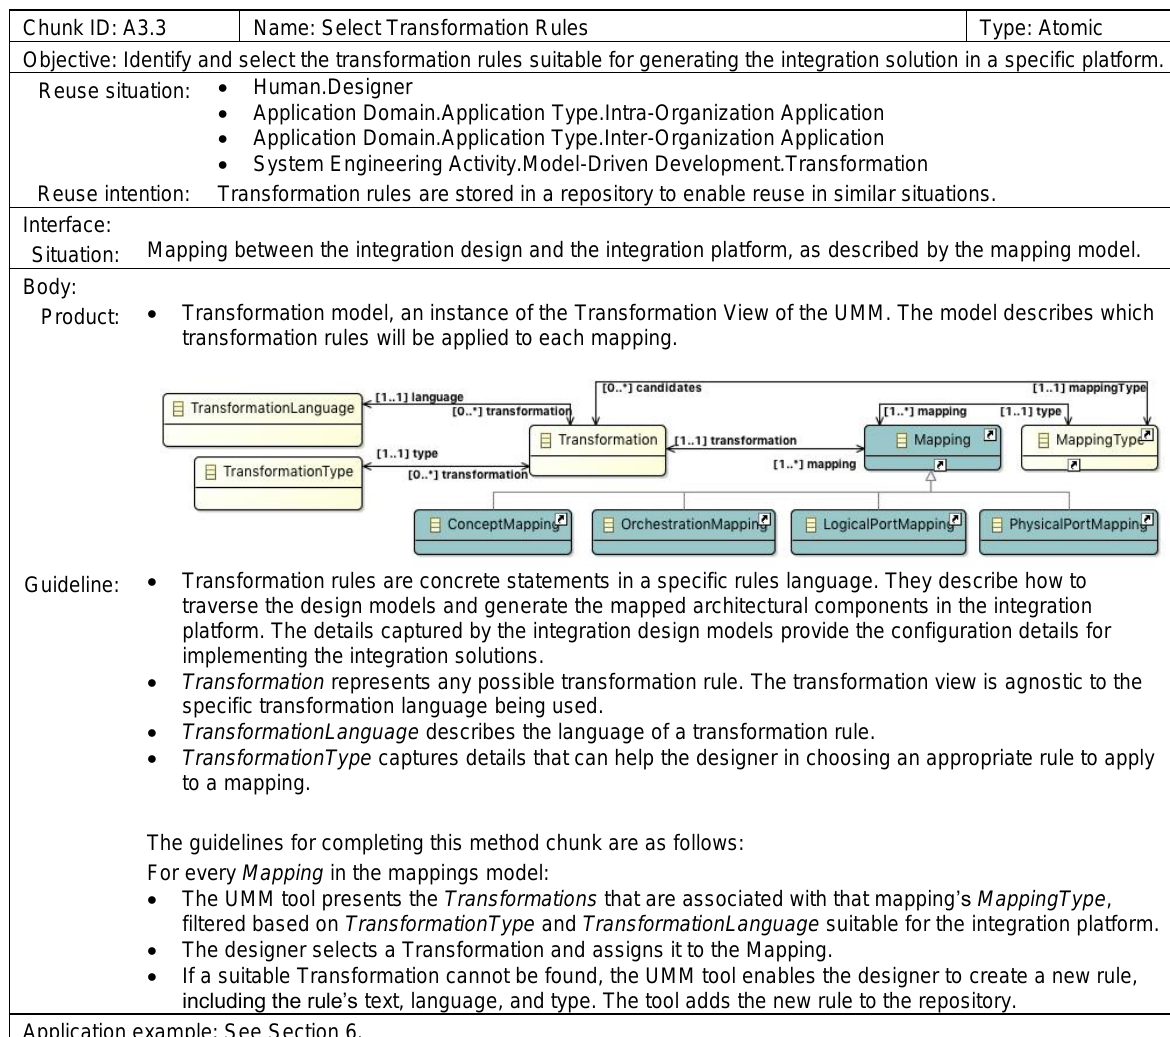
Table 10. Definition of method chunk A3.3